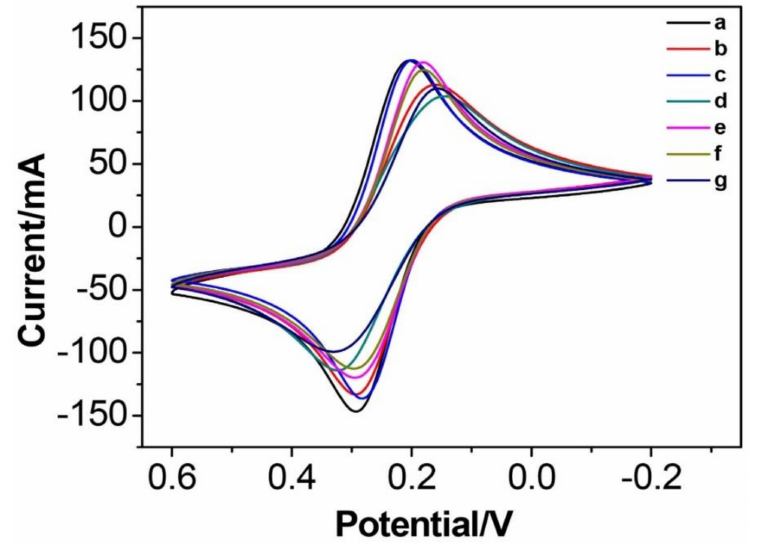
Figure 2. Typical CV measurements of ( a ) the bare gold electrode, ( b ) MPA / Gold electrode, ( c ) G6 PAMAM / MPA / gold electrode, ( d ) G6 PAMAM-COOH / MPA / gold electrode, ( e ) Anti-EpCAM /